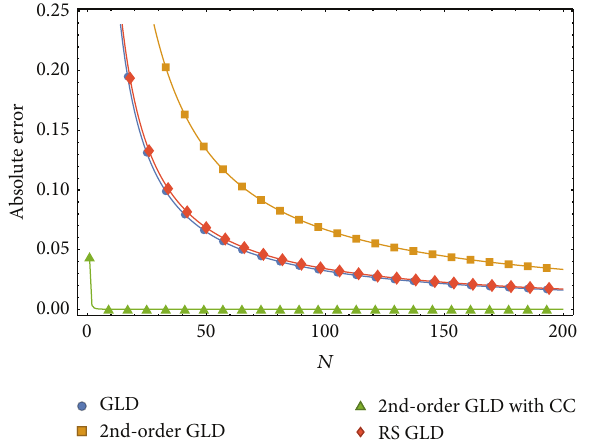
Figure 10: Absolute error over varying values of Δ𝑡 for four different